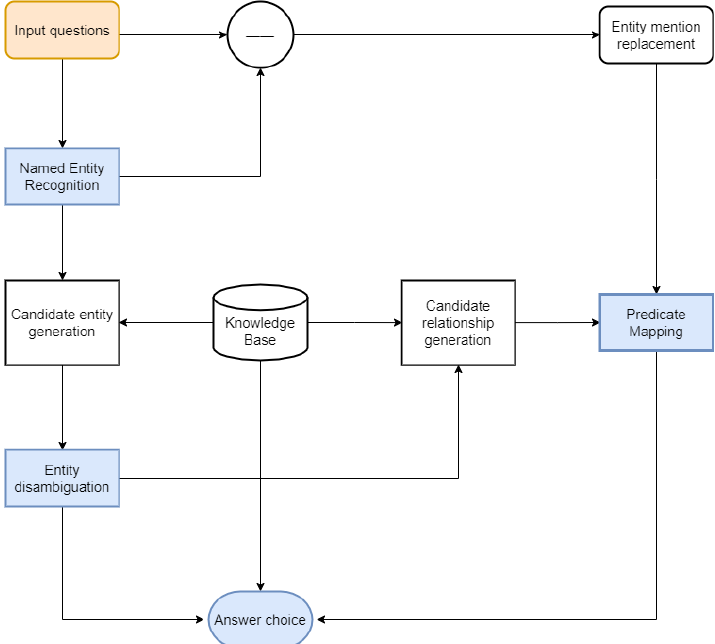
Figure 6. The overall process of the BAT-KBQA framework. (The modules of the three cores have been marked with bright